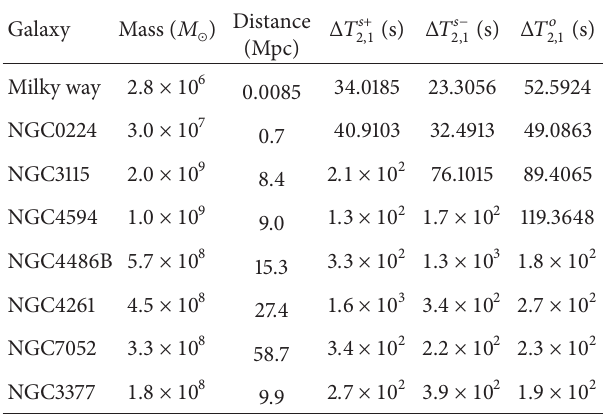
Table 6: Estimation of time delays of the supermassive BHs located at the center of galaxies for ordinary global monopole ( 𝜉 = 1 ) with 𝜂 = 0.2 .